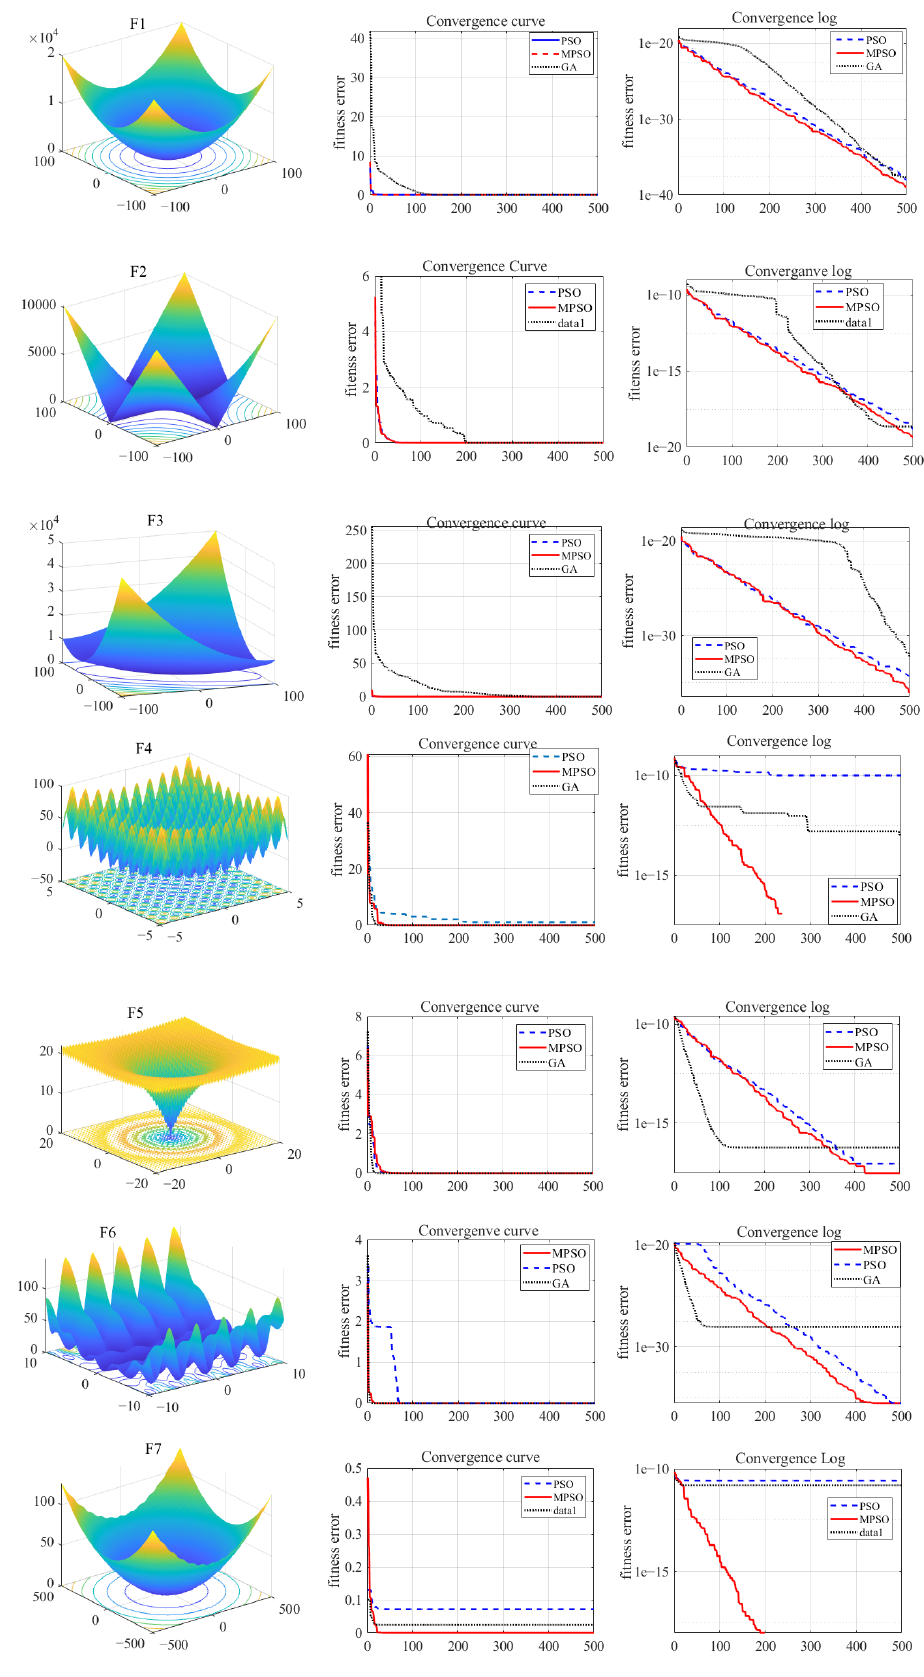
Figure 5. Performance analysis of genetic algorithm (GA), PSO and MPSO optimization on unimodal ( F1 – F3 ) and multi- modal ( F4 – F7 ) benchmark